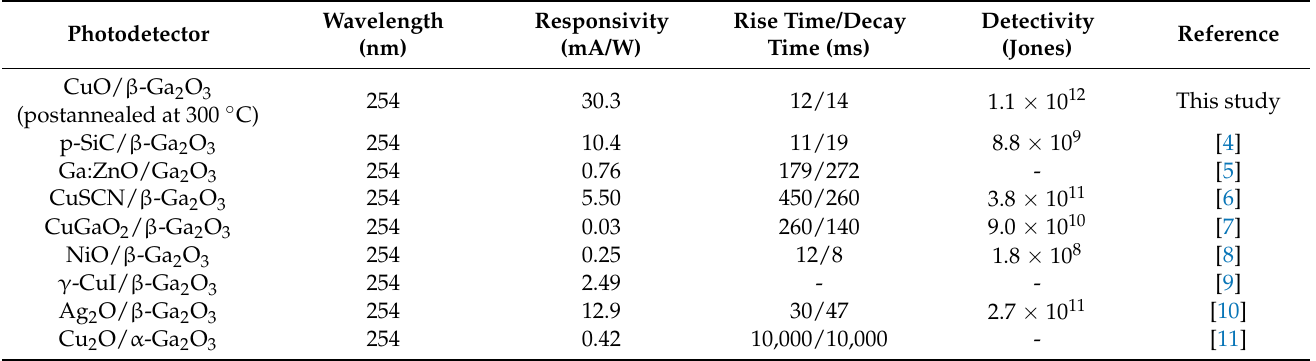
Table 4. Comparison of photoresponse characteristics of solar-blind UV self-powered photodetectors under zero bias in previous studies and in this